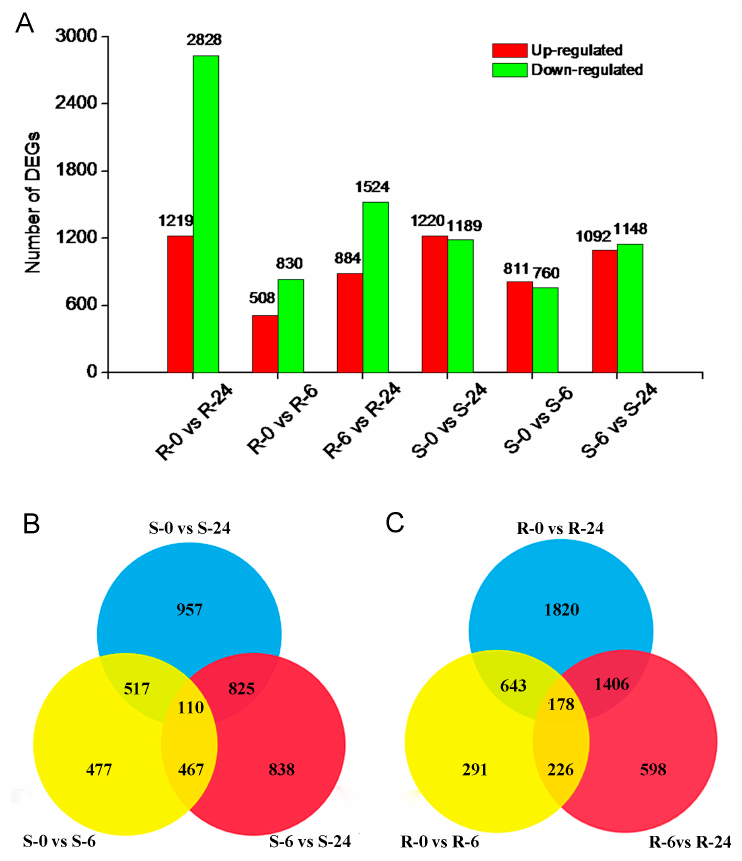
Figure 2. Summary of differentially expressed genes (DEGs) under 6 and 24 h sorbitol treatment; ( A ) Summary of the numbers of up- and down-regulated DEGs in shoots and roots; ( B ) DEGs expressed at random two time point in shoots; ( C ) DEGs expressed at random two time point in